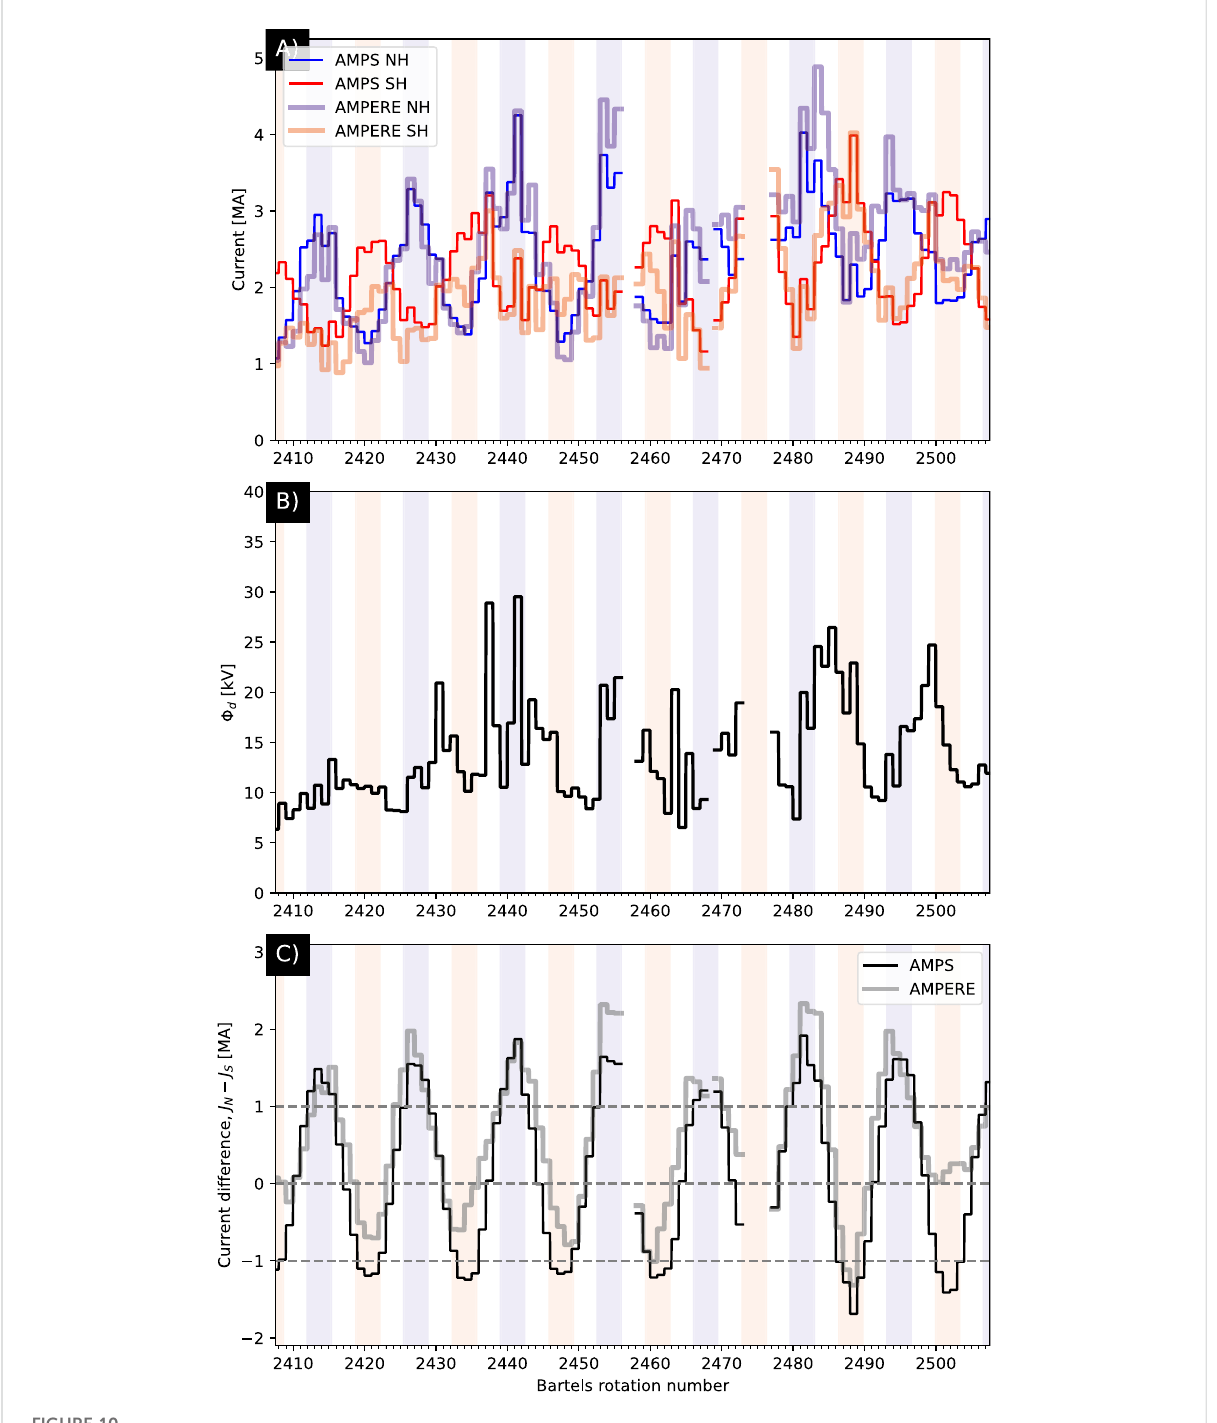
FIGURE 10 Comparison of the total fi eld-aligned current in the two hemispheres and between our model and AMPERE, as a function of Bartels rotation number (number of 27-day periods since 8 February 1832). (A) Thick lines indicate AMPERE currents, and thin lines indicate AMPS model currents. Northern and Southern Hemisphere lines are indicated in blue and red, respectively. The red and blue shades in the background indicate the three months around June (blue) and December (red). (B) Dayside reconnection rate, in kV, using the (Milan et al., 2012) coupling function. (C) The difference in total current between hemispheres. The format of this fi gure is similar to that of Figure 3a in Coxon et al.